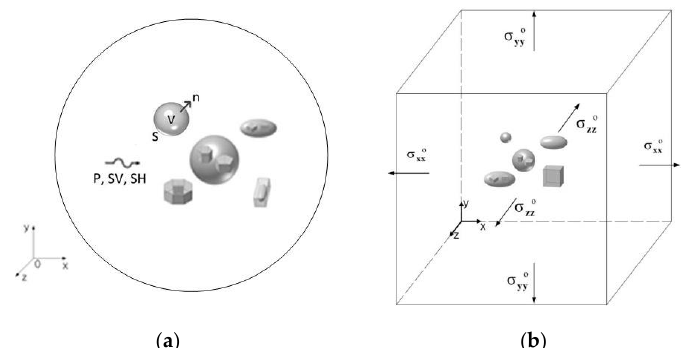
Figure 2. Geometry of the general ( a ) elastodynamic and ( b ) elastostatic problem.